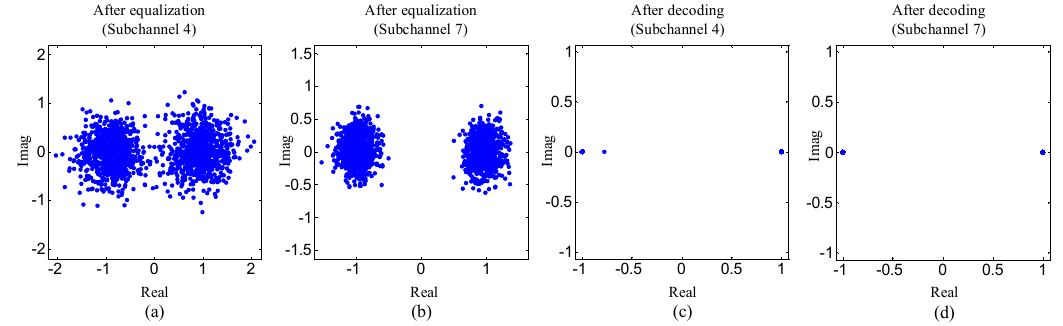
Figure 10. Scatterplots for subband four and seven of the proposed method with BPSK mapping: ( a ) and ( b ) the scatterplots indicating the estimated symbols after equalization; ( c ) and ( d ) the scatterplots indicating the mean of the symbols after decoding.